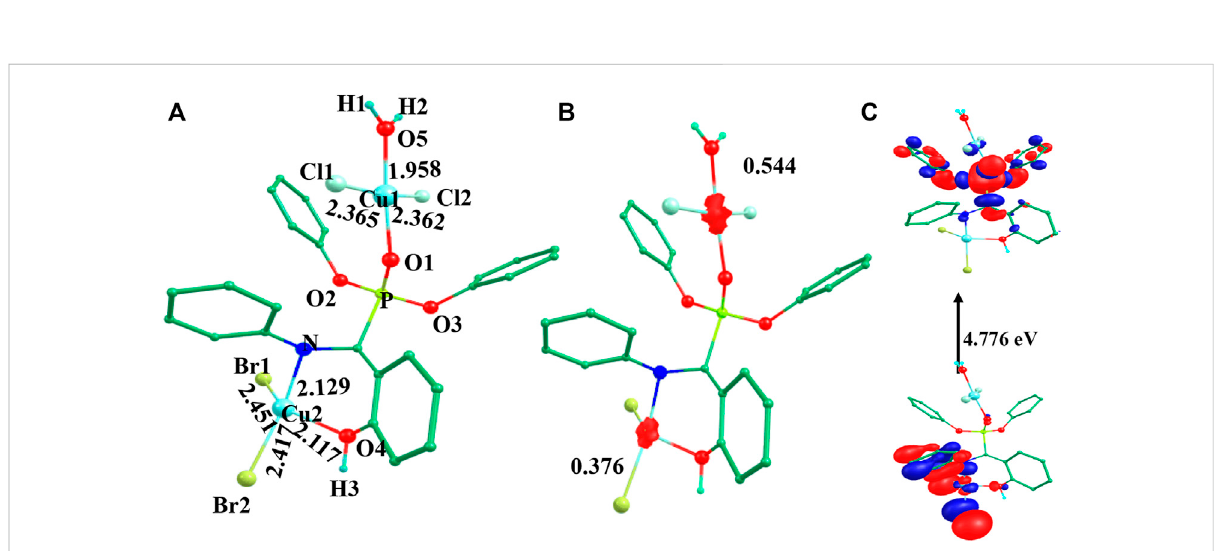
FIGURE 3 B3LYP-D2 (A) optimized structure, (B) spin density plot and (C) HOMO-LUMO gap of the species 3 V (Bond lengths are in